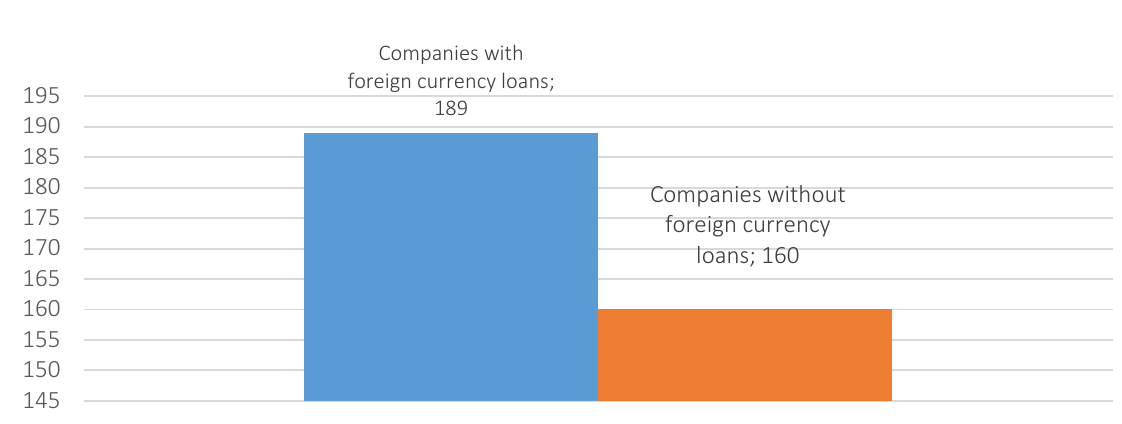
Companies with foreign currency loans; 189